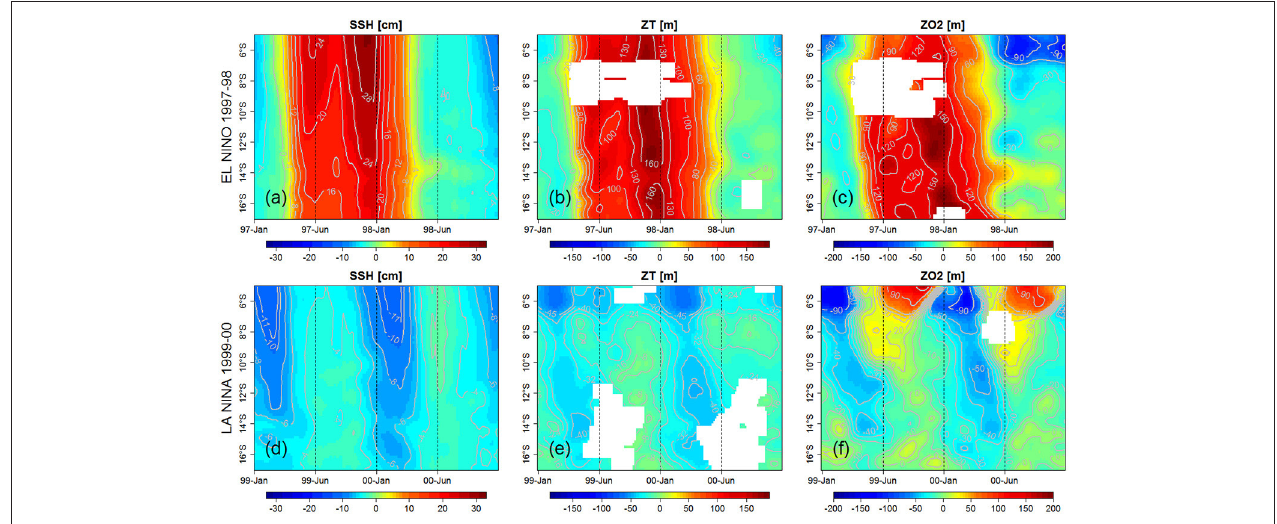
FIGURE 5 | Hovmoller (latitude vs. time) of modeled SSH anomalies ( a,d , in cm), ZT15 anomalies ( b,e , in meters) and ZO2 anomalies ( c,f , in meters) during EN 1997–1998 (top) and LN 1999 (bottom) events. Model values were averaged within 100km to the coast. All variables were filtered in time (60 days moving average) and space (100km alongshore). Empty data in (b,c,e,f) means that ZT15 and ZO2 were not